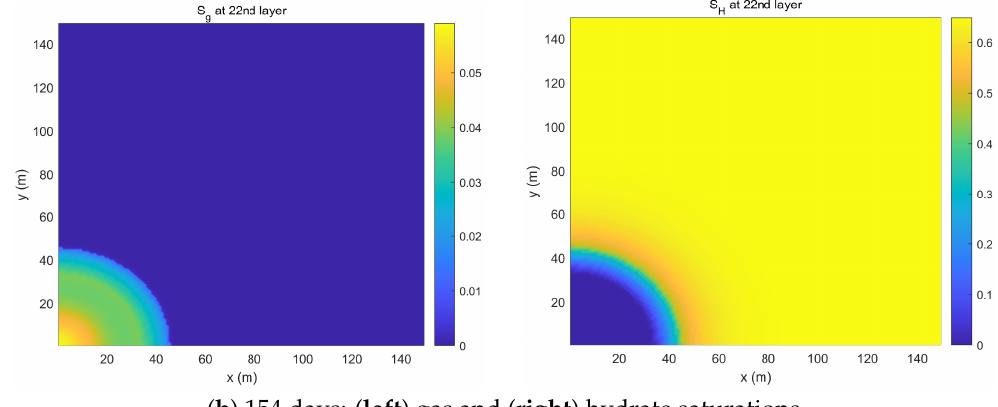
Figure 9. Gas and hydrate saturations in the converted 3D Cartesian domain at the 22nd layer within the SS: ( a ) after 100 days and ( b ) after 154 days. The origin is where the wellbore is located.